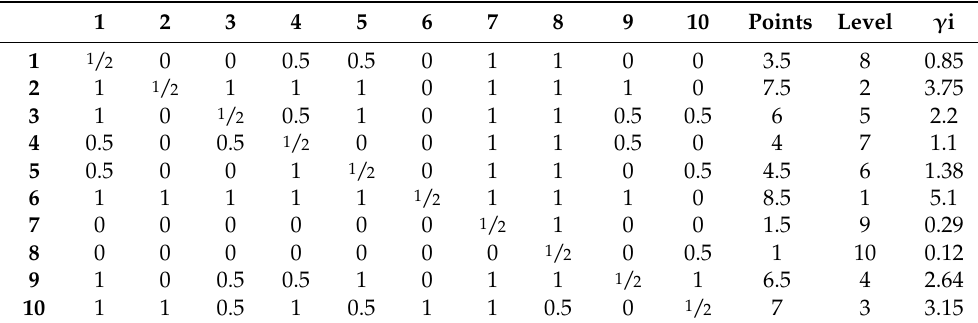
Table 3. Multicriteria